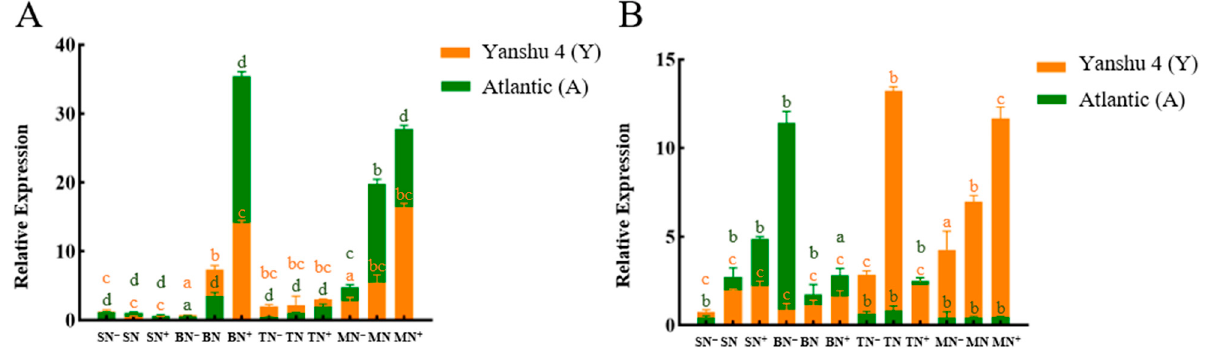
Figure 1. Relative expression of nitrate reductase gene StNR in two genotypes of potato under different N supply levels. ( A ) Leaf (L); ( B ) Root (R). S, B, T, and M represent seedling stage, budding stage, tuber expansion stage, and mature stage, respectively. N − , N, N + are different N supply levels, representing low N, normal N, and excess N, respectively. Different letters indicate the difference of relative gene expression in different periods under different N application levels ( p < 0.05).